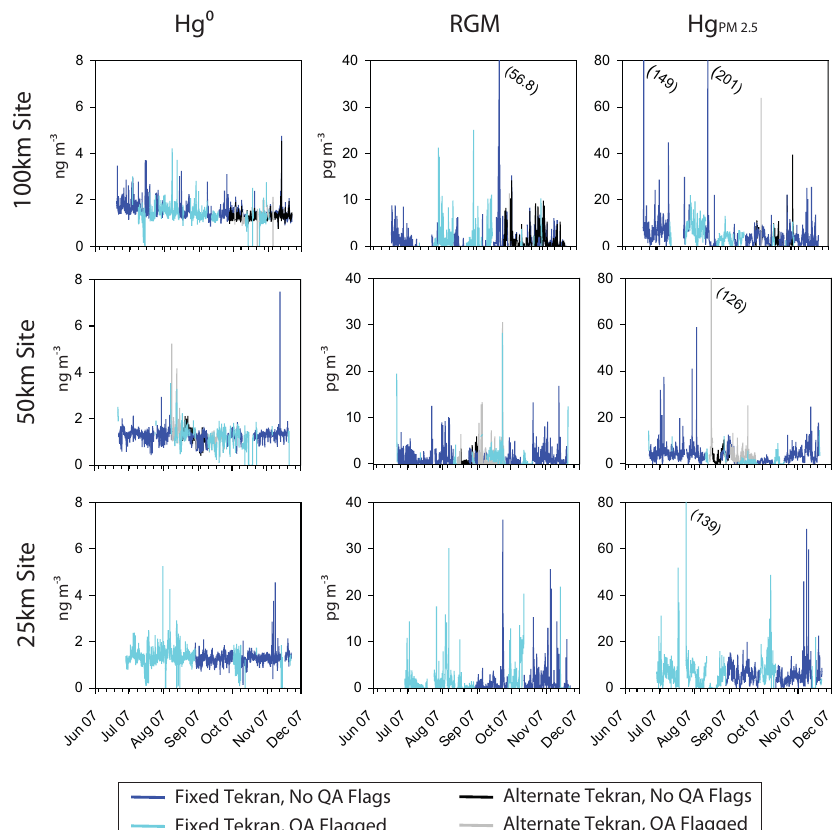
% nd = percent of samples below method detection limits.